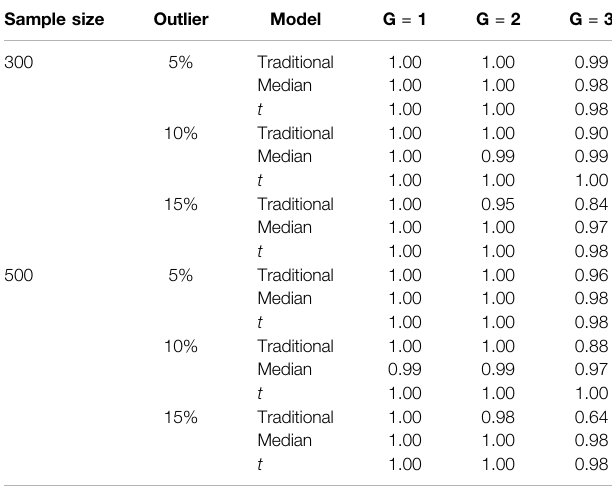
TABLE 3 | Proportion of converged datasets.